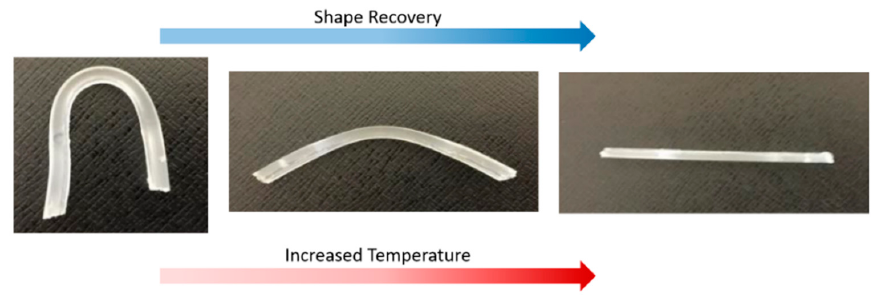
Figure A2. Shape recovery of the bent solid SMP beam (temporary shape) into the originally programmed straight shape after heating above the SMP’s T g .